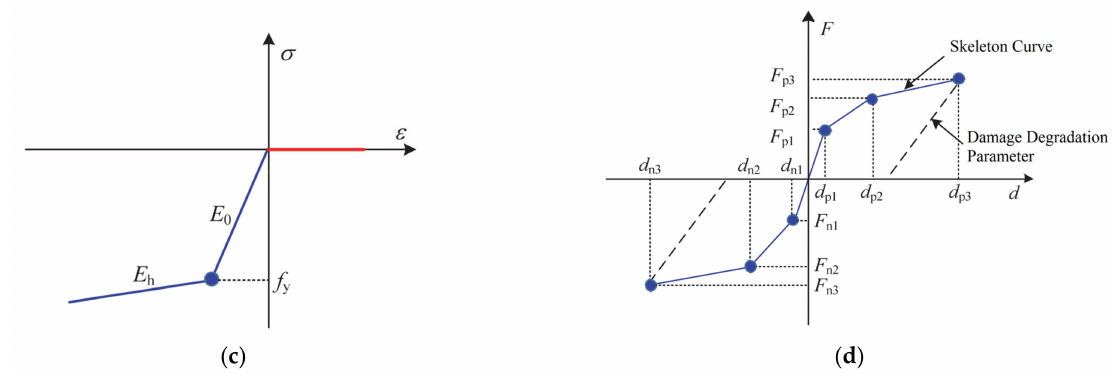
Figure 4. Constitutive models of materials: ( a ) concrete02; ( b ) steel02; ( c ) ElasticPPGap; ( d )